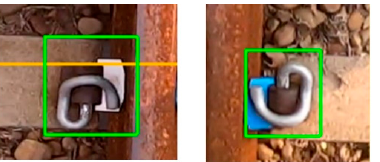
Figure 4. Two samples of light loose (X) track fasteners.